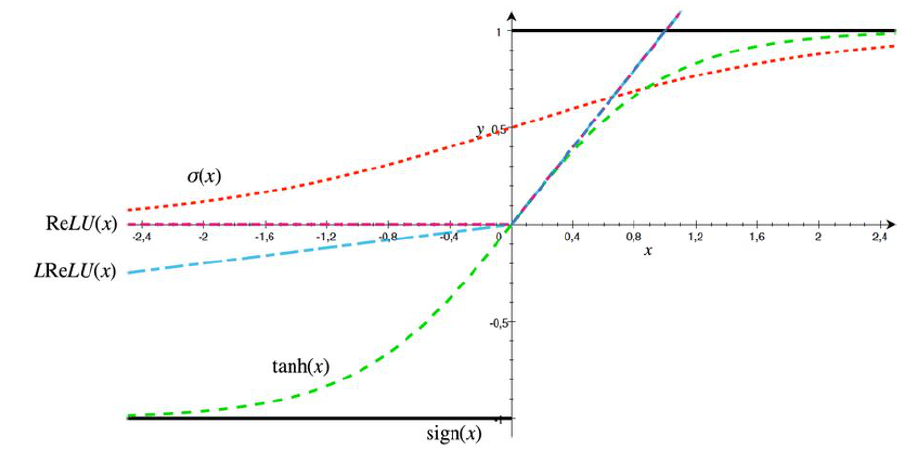
Figure 1. New and classic activation